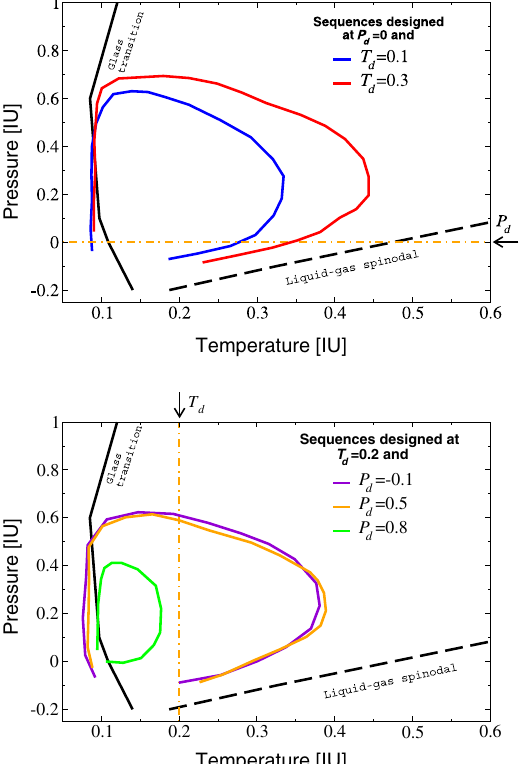
FIG. 9. Average stability regions for proteins designed according to the MAX GAP protocol. Average stability regions for proteins designed along the isobar P d ¼ 0 and the isotherm T d ¼ 0 . 2 IU, respectively, shown in panels (a) and (b). Arrows point at the design pressure P d ¼ 0 IU and to the design temperature T d ¼ 0 . 2